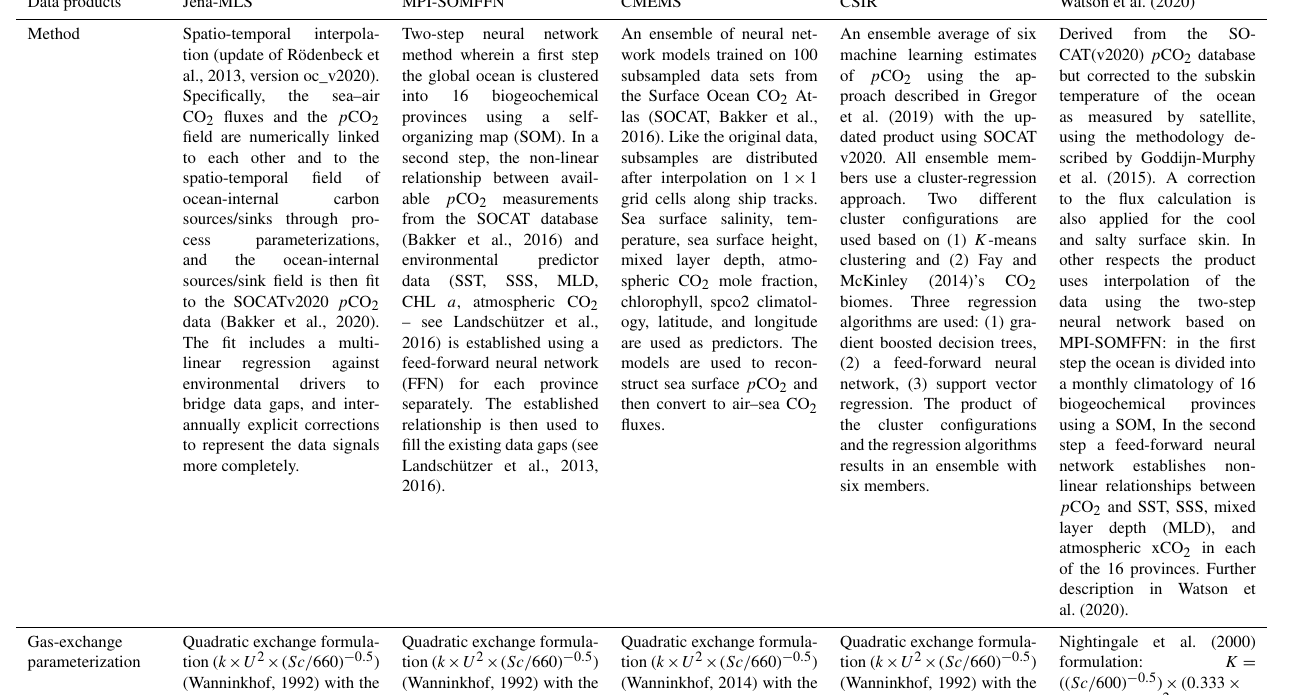
Table A3. Description of ocean data products used for assessment of S OCEAN . See Table 4 for references. Data